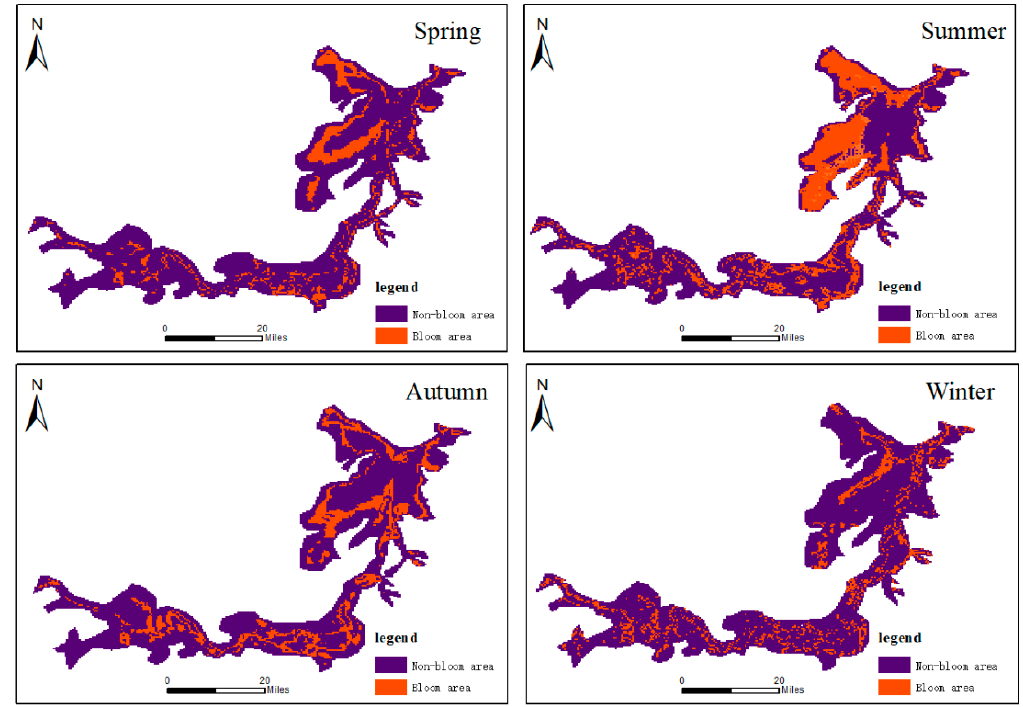
Figure 9. Changes in algal blooms in Dongting Lake in spring, summer, autumn, and winter from 2001–2017.